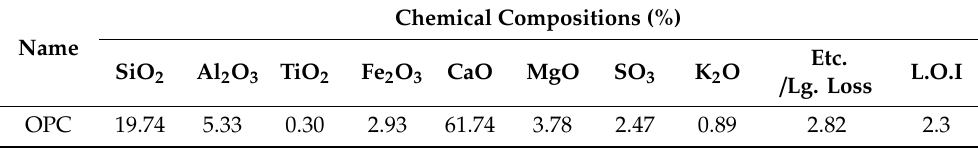
Table 1. Chemical compositions of cement.